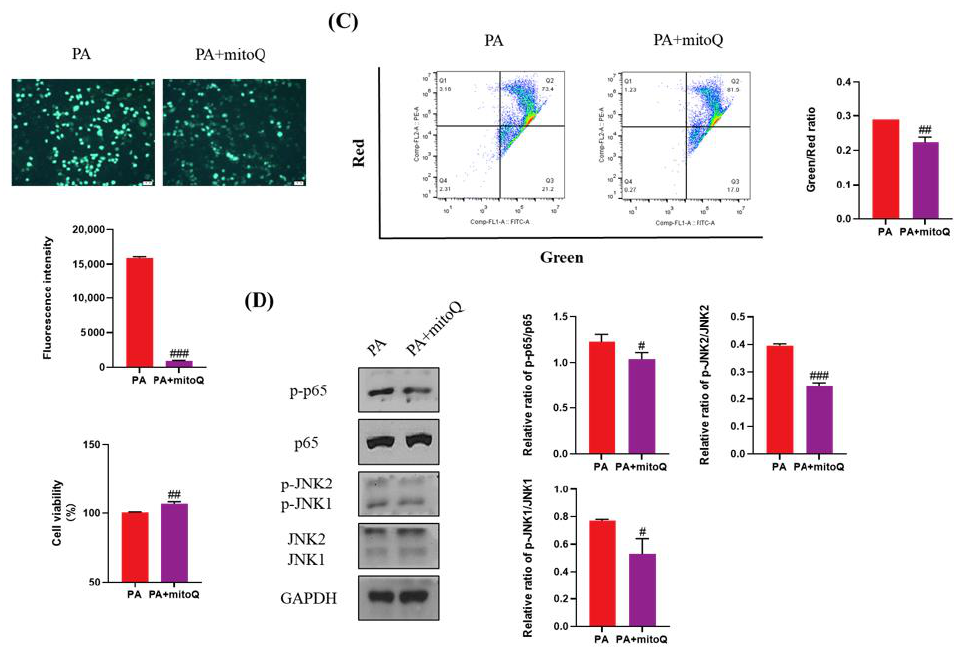
Figure 7. The protective effects of mitoQ on PA-induced lipotoxicity in LO2 cell lines. ( A ) mitoQ (500 nM) treatment strikingly inhibited the ROS generation in PA-treated LO2 cells. ( B ) mitoQ treatment notably improved cell viability in LO2 cells. ( C ) mitoQ treatment ameliorated the loss of mitochondrial membrane potential in LO2 cells. ( D ) mitoQ downregulated the phosphorylation of JNK1, JNK2, and p65 in PA-treated LO2 cells. All data are expressed as mean ± SD. # p < 0.05, ## p < 0.01, and ### p < 0.001 versus PA. PA, PA-treated control group; PA + mitoQ, PA-treated